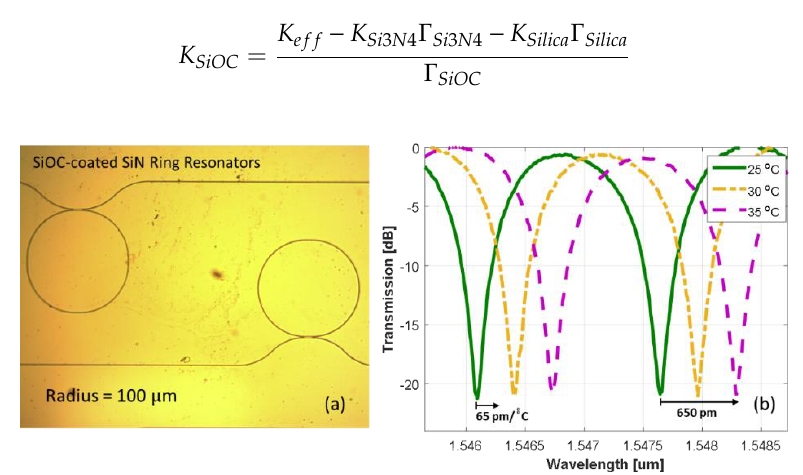
Figure 4. ( a ) Optical micrograph of SiOC-coated Si 3 N 4 micro-ring resonators ( b ) optical transmission spectrum of ring resonator at different temperatures.